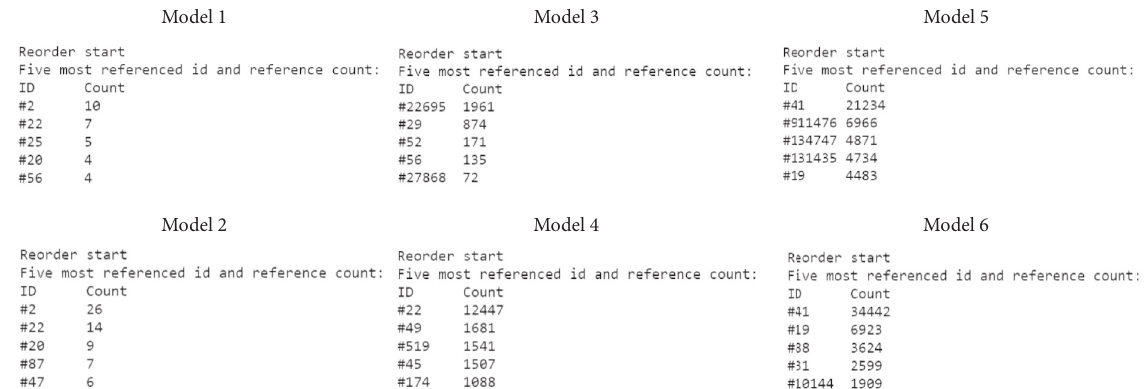
Figure 9: A demonstration of reference count statistics extracted from the original